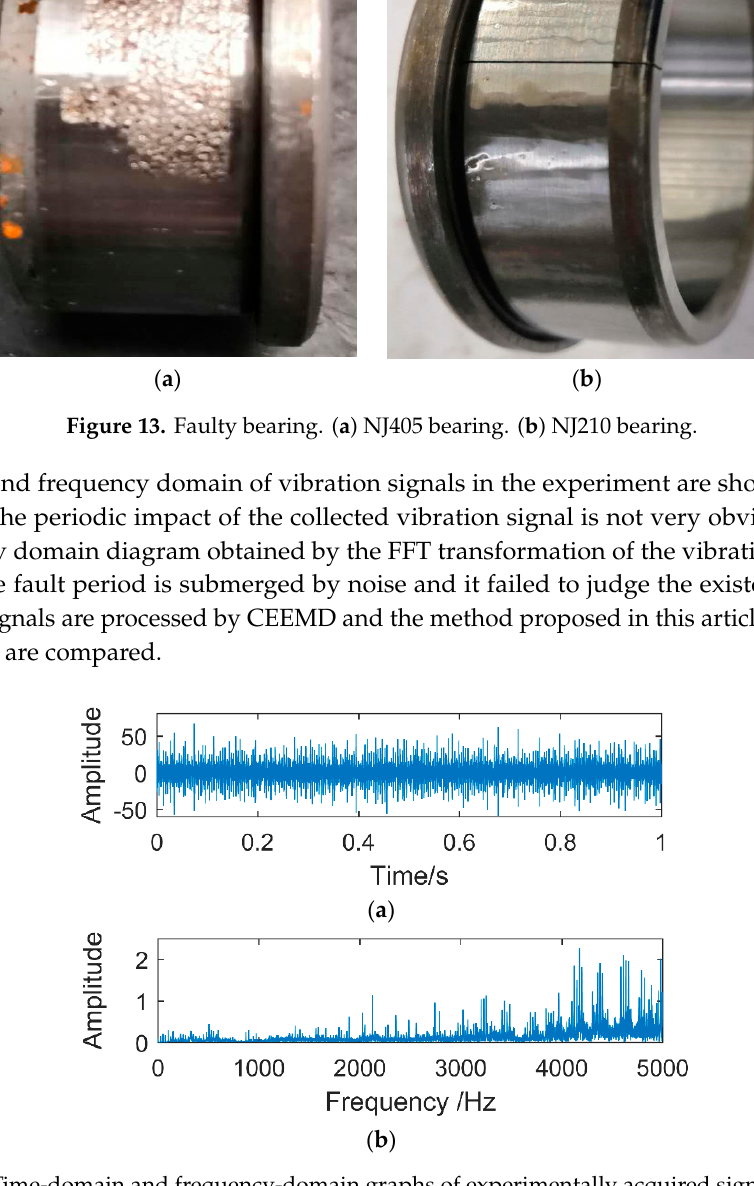
Figure 12. Experiment bench, 1—Magnetic Powder Loader; 2—Gear speed Increaser; 3—Torque and Rotational Speed Sensor; 4—Planetary Reducer; 5—Triaxial Acceleration Sensor #1; 6—Triaxial Acceleration Sensor #2; and 7—Triple-phase Asynchronous Motor.